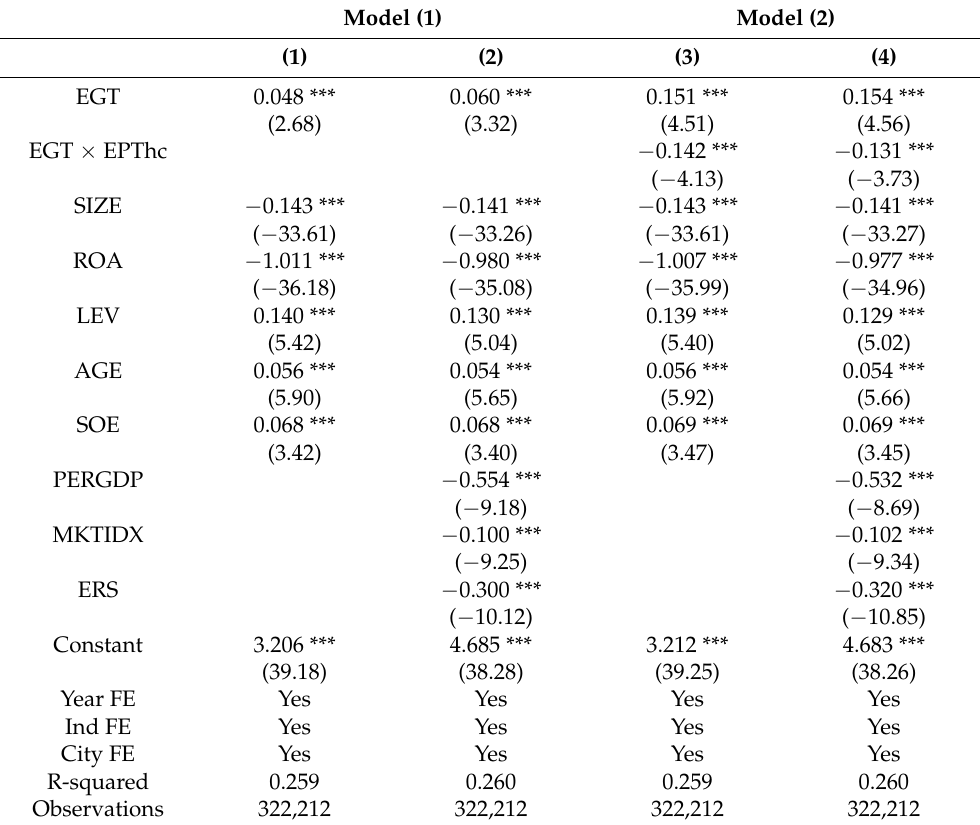
Table 3. Baseline